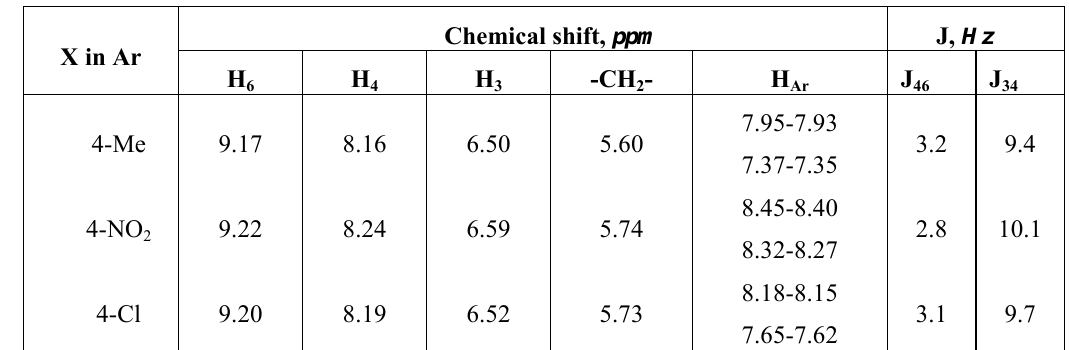
Table 1. 1 H-NMR spectra of pyridones I